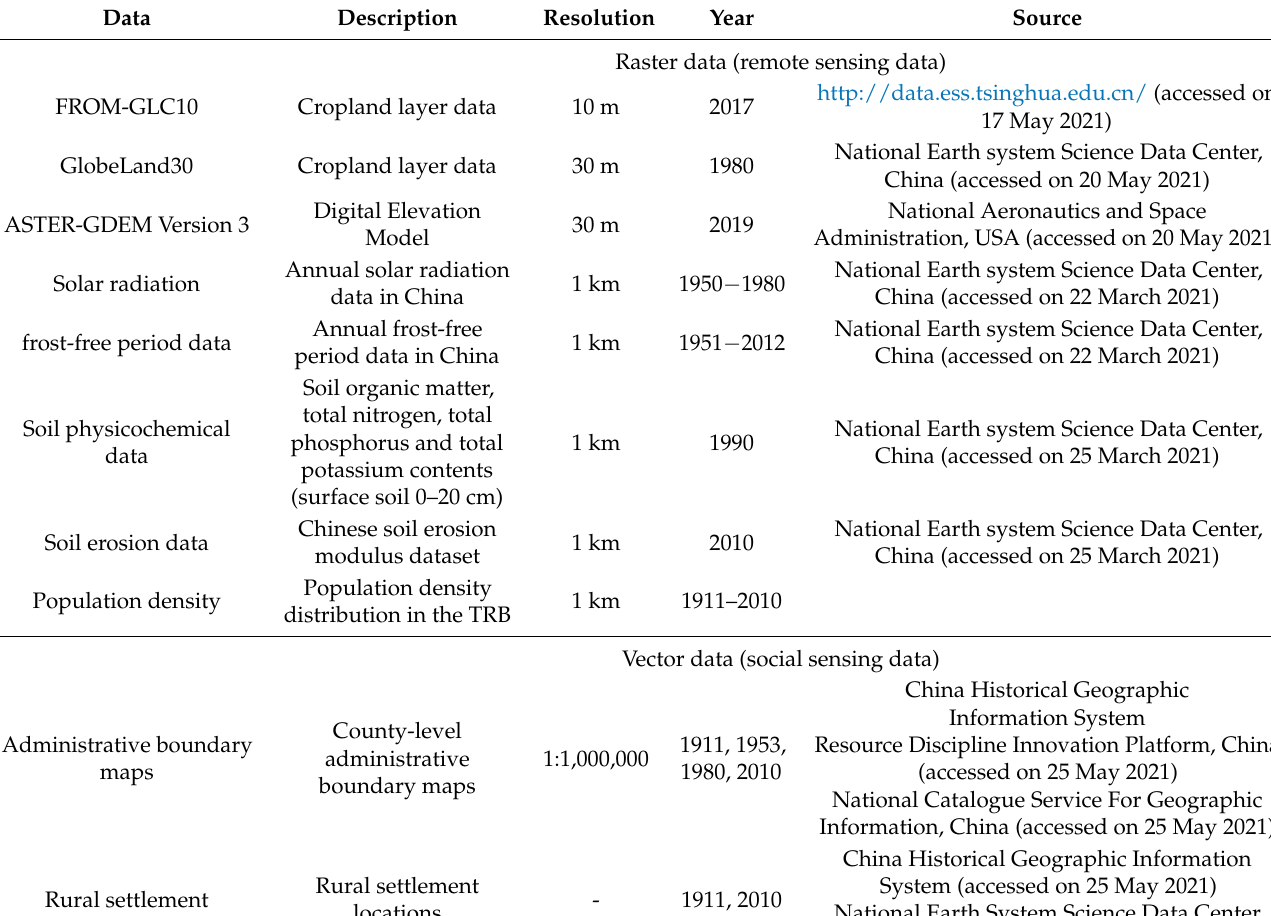
Table 1. List of ancillary data used in this